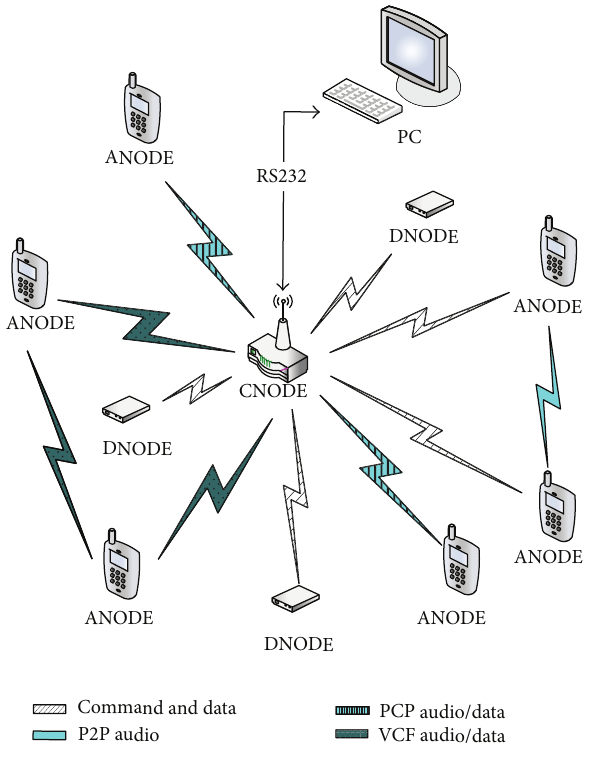
Figure 3: Network